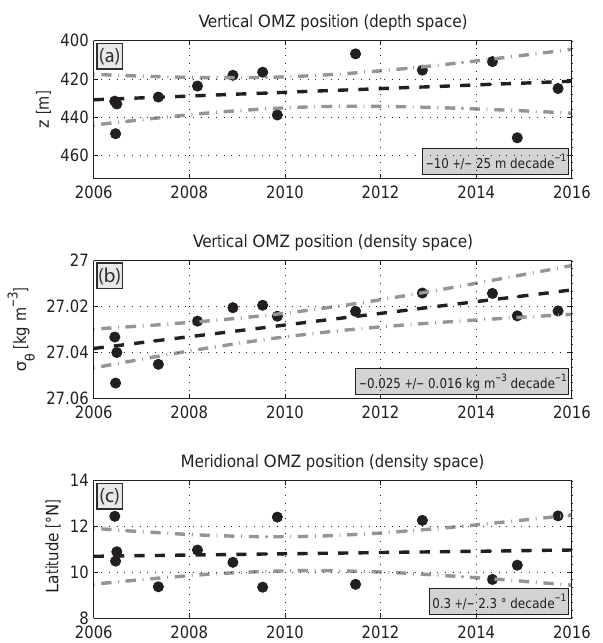
Figure 9. Time series (black dots) of the OMZ core position (de- fined as the 5% area of lowest oxygen) obtained from individual ship sections along 23 ◦ W. Panels (a) and (b) show the vertical po- sition in depth and density space. Panel (c) shows the meridional position in density space (that is similar in depth space). The black dashed line shows the respective linear trend with the 95% confi- dence band (gray dashed-dotted lines).